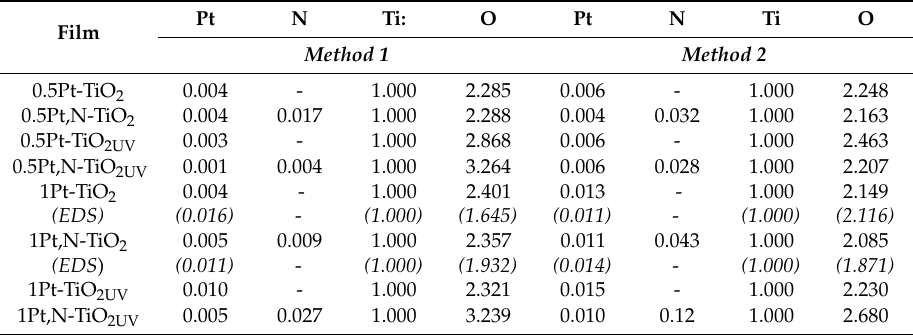
Table 2. Atomic ratios of the elements on the surface (XPS) and bulk (EDS data of some films are presented in brackets).